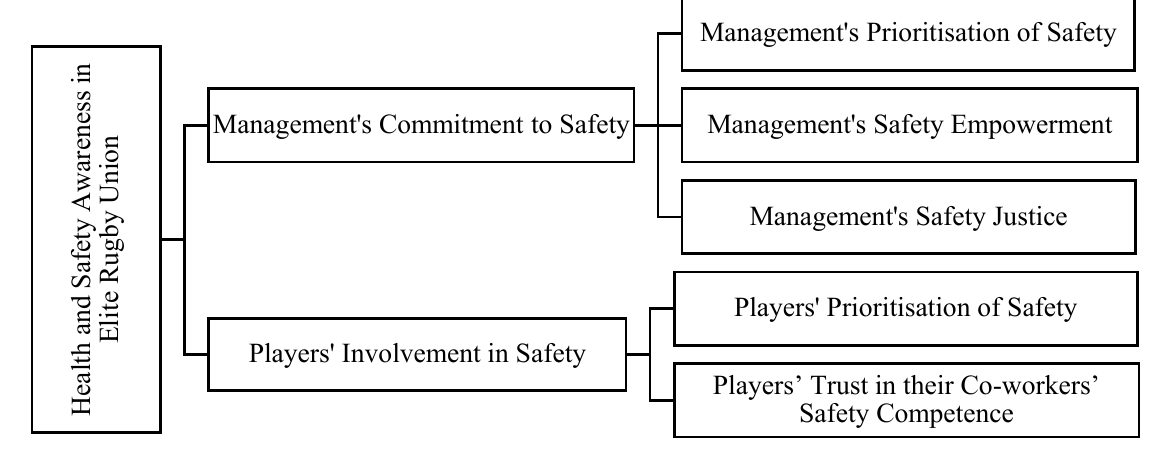
Figure 1. Health-and-Safety-Awareness Framework in Elite Rugby Union.